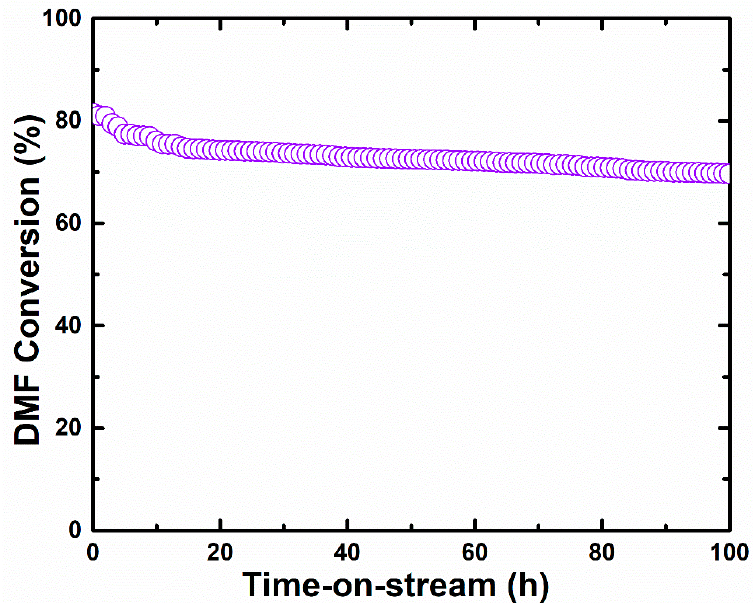
Figure 10. Time-on-stream conversion of DMF catalyzed by cerium oxide after 100 h.